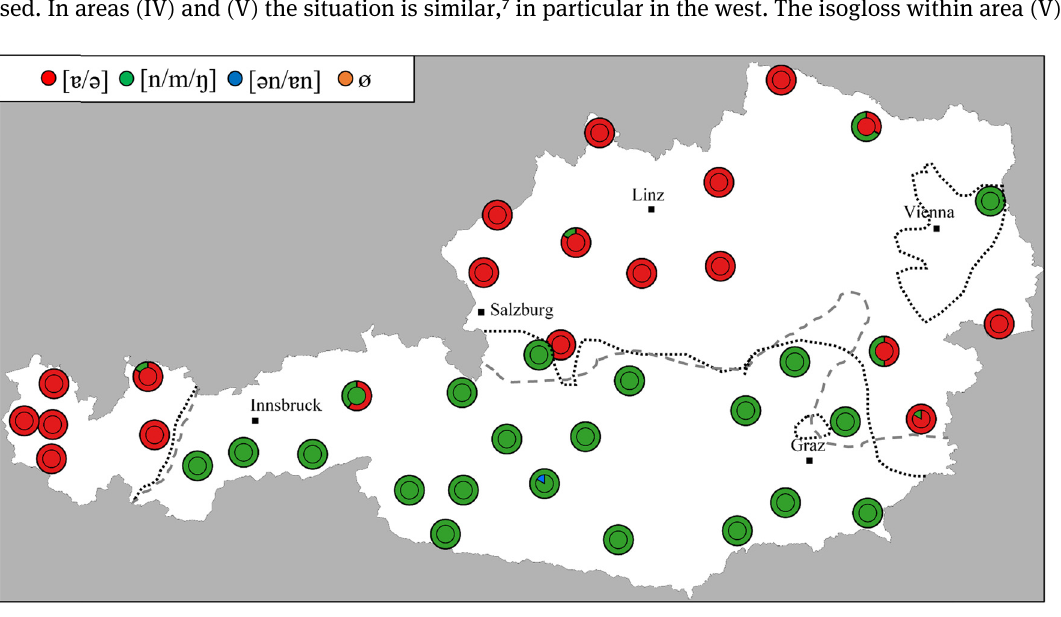
Figure 4: ( en ) following palatovelar fricatives ( inner circles = percentage of variants realised by older speakers; outer circles = percentage of variants realised by younger speakers )